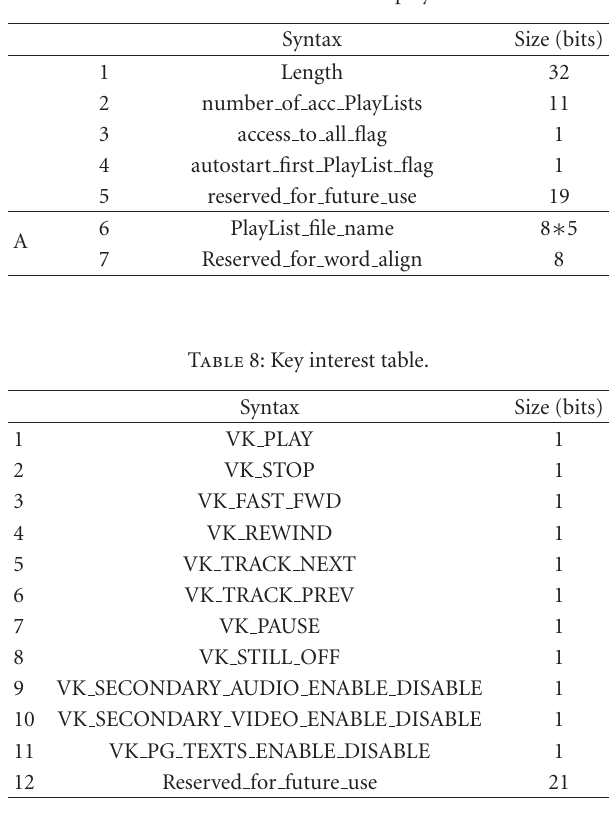
Table 7: Table of accessible playlists.